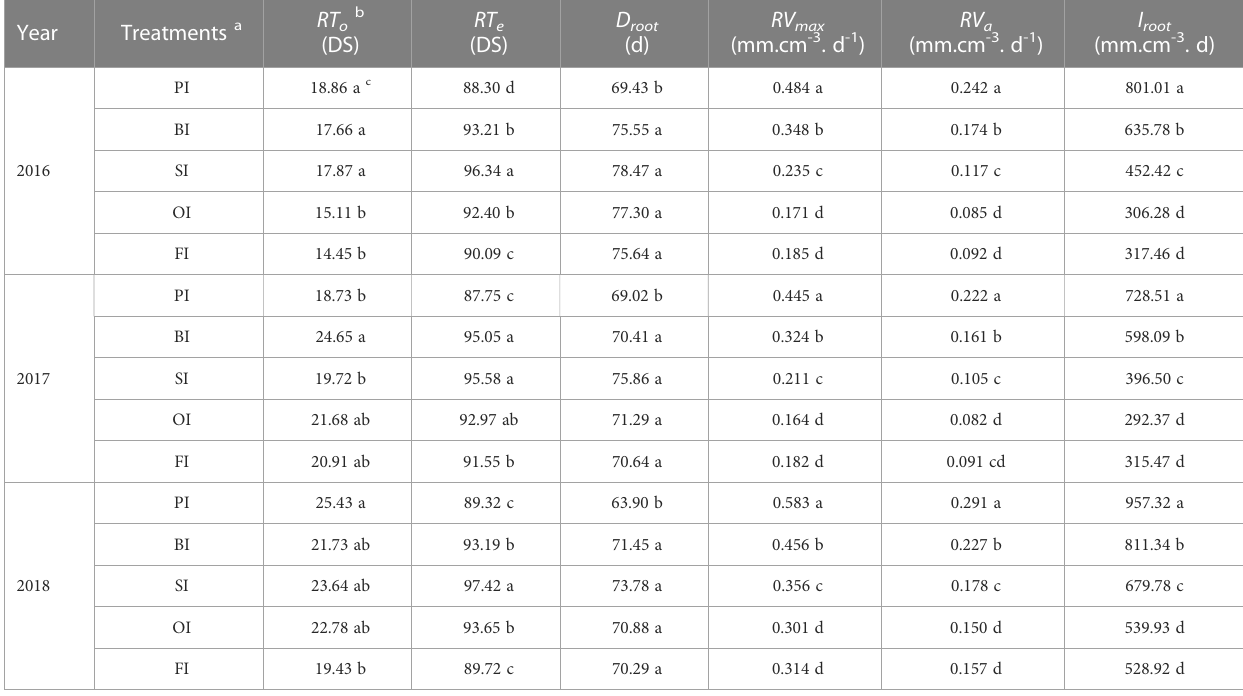
TABLE 4 Root senescence traits with the different drip irrigation